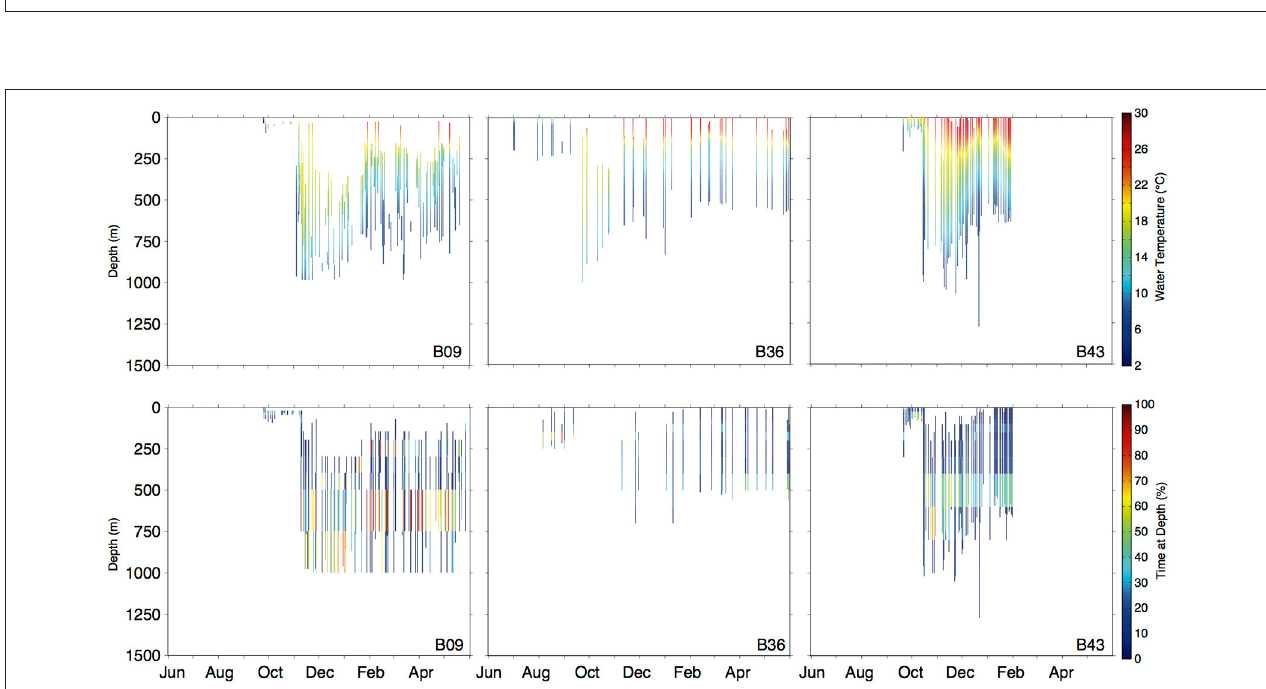
FIGURE 6 | Daily depth-temperature profiles (row 1) and time-at-depth profiles (row 2) for three representative basking sharks (tracks plotted in Figure 5B ). Note differing time scales (x-axis) among individuals.